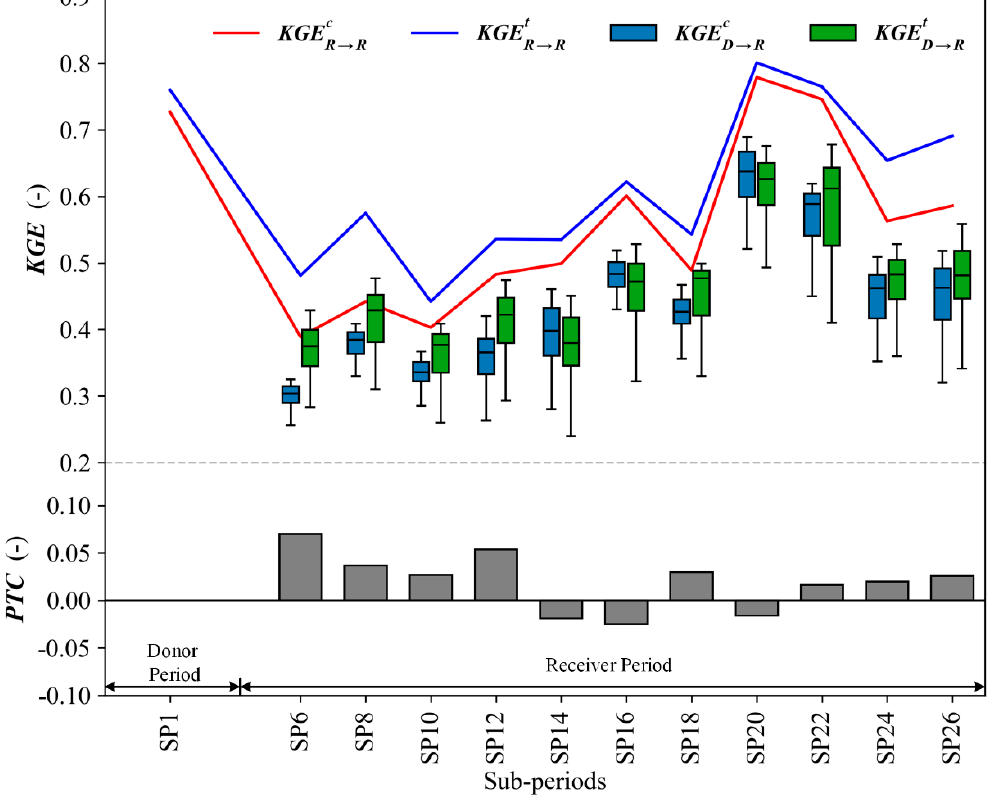
Figure 8. Comparison of streamflow simulation performance in terms of KGE when parameter sets calibrated during P1 are transferred to other sub-periods (SP6–SP26) for the GR4J model and the GR4J-T model in Weihe Basin. The boxplots represent the KGE values using the 5000 parameter sets obtained from SP1. The PTC values indicate the difference of the average simulation performance between the GR4J model and the GR4J-T model during the validation procedure.